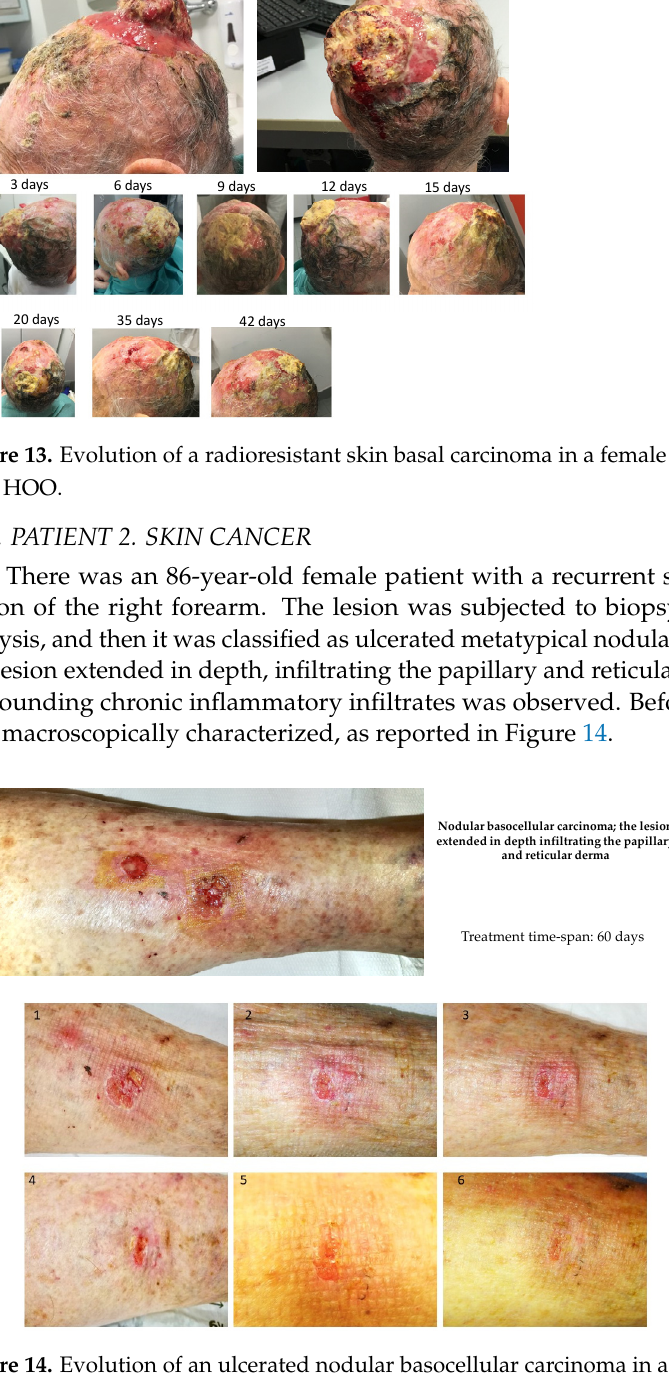
Figure 14. Evolution of an ulcerated nodular basocellular carcinoma in a female 86-year-old patient. The lesion extended in depth, infiltrating the papillary and reticular derma; the presence of surround- ing chronic inflammatory infiltrates was observed before treatment (T0). HOO treatment induced cancer regression and disappearance of the surrounding inflammatory halo after 60